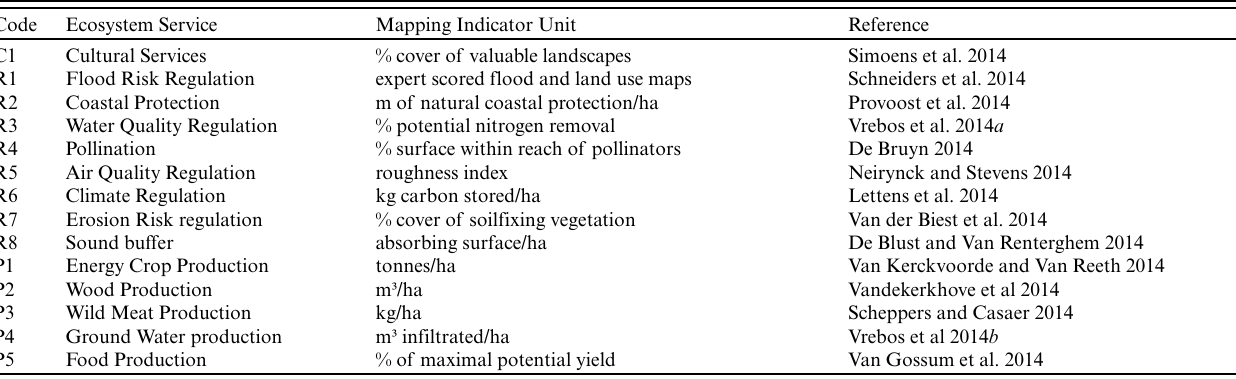
Table 2 . Ecosystem services considered in this study, the quantification units used for supply mapping (indicator), and the respective reference chapter of the Flanders regional ecosystem service assessment (Jacobs et al. 2014 a, Stevens et al. 2015). References of individual chapters are listed in Appendix 9. For the biophysical and monetary estimates (wood production, climate regulation, food production, water quality regulation, and flood risk regulation) additional data from the ECOPLAN project was